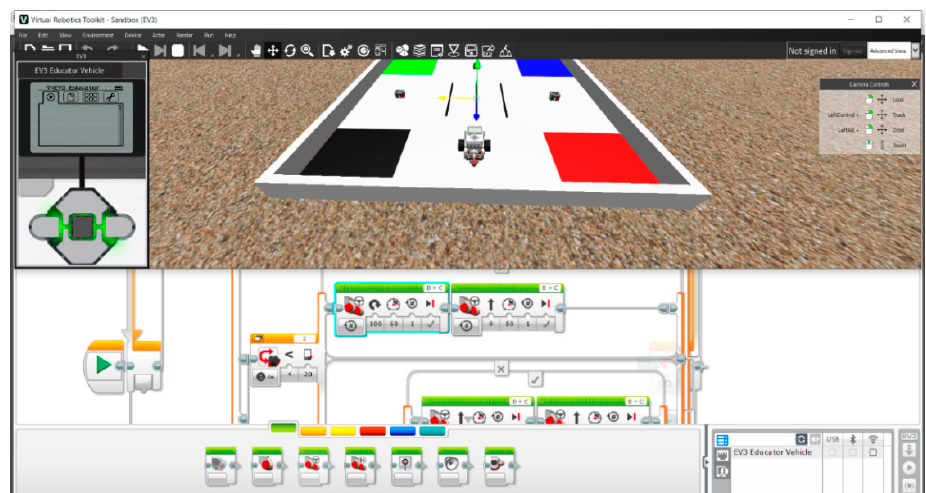
Figure 6. The virtual environment of the Virtual Robotic Toolkit.